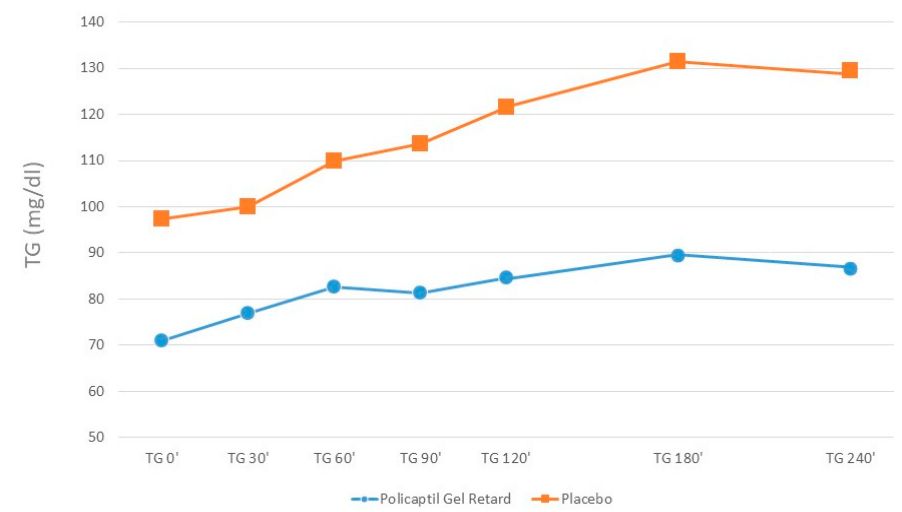
Figure 1. Triglycerides serum concentration before and after the ingestion of PGR or placebo.